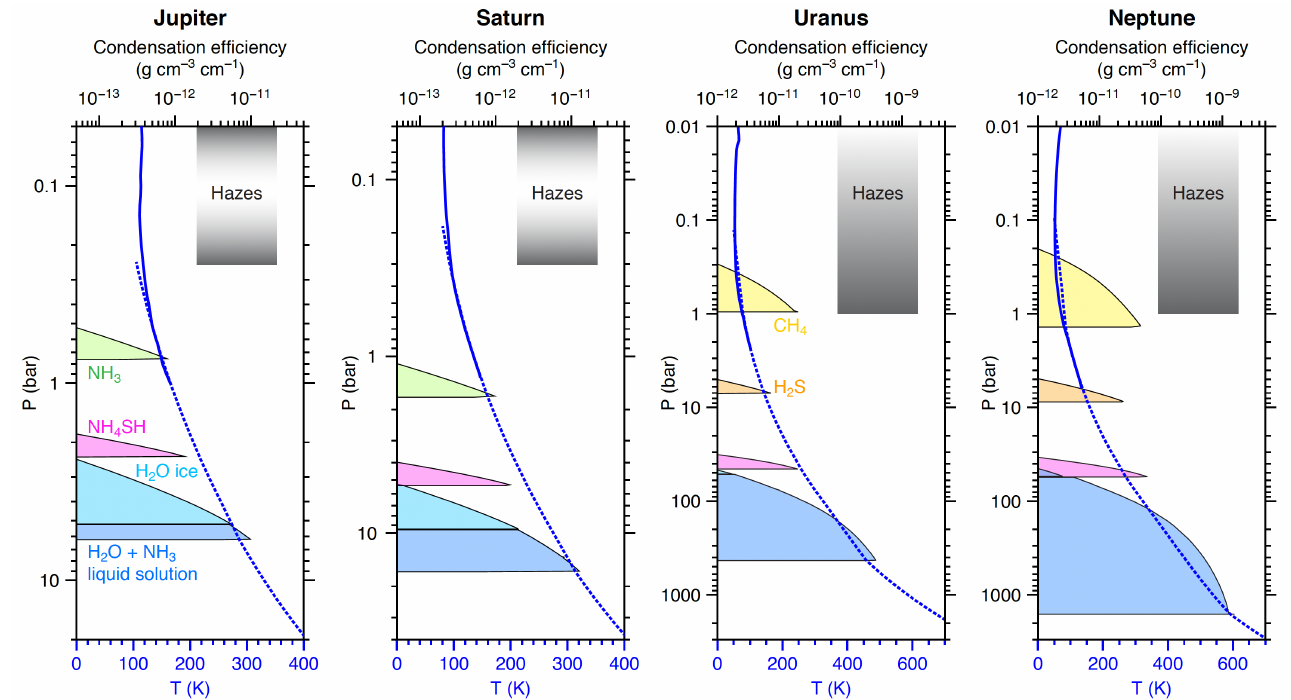
Figure 14. Cloud layers on the giant planets. Calculations use composition described in [149] (and references therein) for non-condensable species and [148] (and references therein) for condensable species, with adiabatic model temperatures (dashed blue curves) matched to Voyager 2 radio occulta- tion temperature profiles (solid blue curves, [73]), in the model of [71,149,150]. Cloud condensation efficiency is plotted for each layer. Qualitative vertical ranges of photochemical hazes are shown by grey shading for